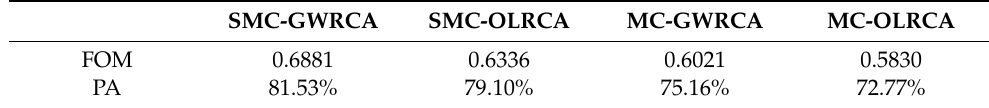
Table 3. Simulation precision testing of four